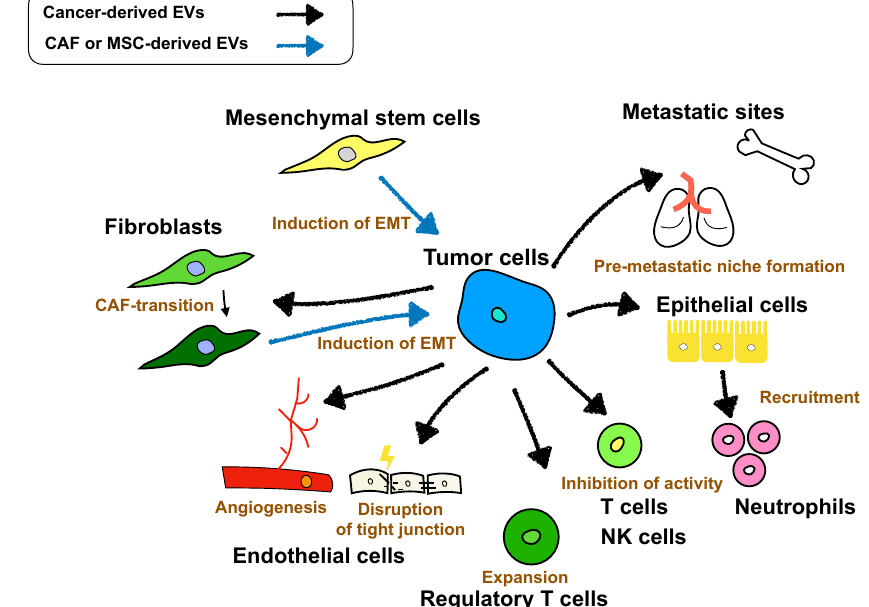
Figure 1. Cell-to-cell communication between tumor cells and surrounding cells via “extracellular vesicles” (EVs) in metastasis. Cancer-derived EVs contribute to cancer metastasis by educating primary and distant tumor environmental cells. In the metastatic process, cancer-derived EVs induce angiogenesis or disrupt tight junctions in ECs, induce cancer-associated fibroblast (CAF) transition, suppress the host immune system, and create a premetastatic niche. Moreover, EVs-derived from cancer surrounding cells, such as CAFs and mesenchymal stem cells (MSCs), also contribute to cancer metastasis.